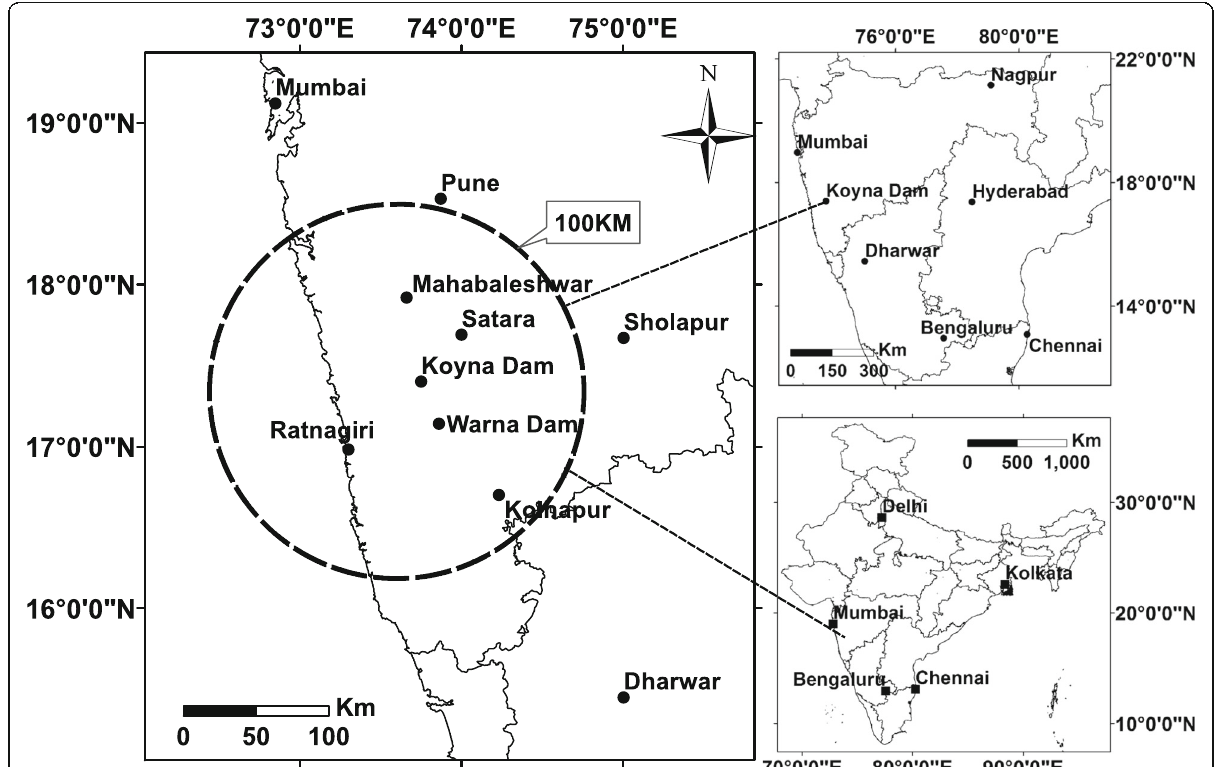
Fig. 1 Location of Koyna region and the Peninsular